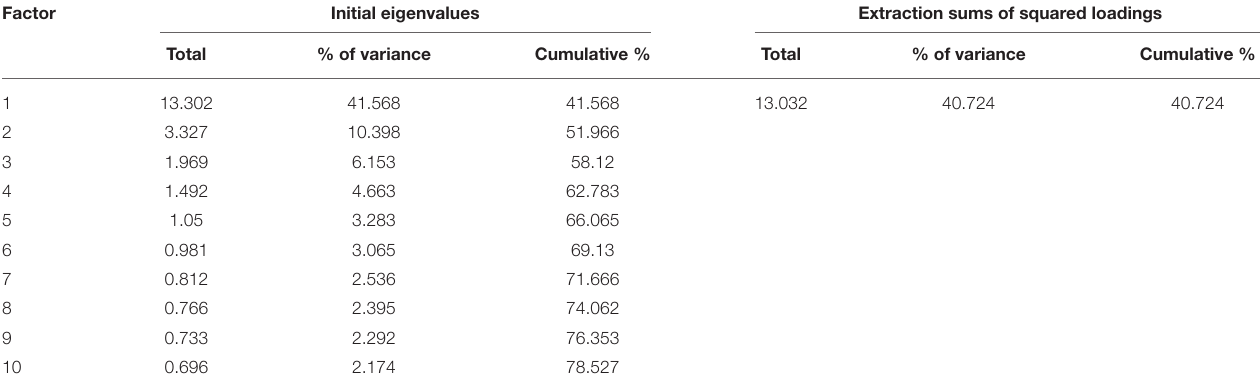
TABLE 2 | CMB total variance explained.